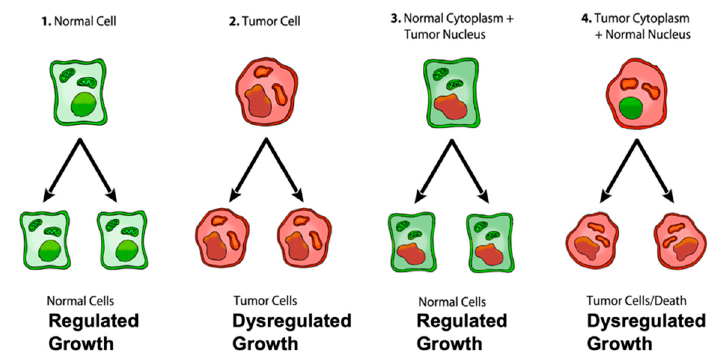
Figure 1. Role of the nucleus and mitochondria in the origin of tumors. Normal cells are shown in green with nuclear and mitochondrial morphology indicative of normal gene expression and OxPhos function, respectively. Tumor cells are shown in red with abnormal nuclear and mitochon- drial morphology indicative of genomic instability and abnormal OxPhos function, respectively. “(1) Normal cells beget normal cells with regulated growth. (2) Tumor cells beget tumor cells with dysregulated growth. (3) Transfer of a tumor cell nucleus into a normal cytoplasm begets normal cells that have regulated growth, despite the presence of the tumor-associated genomic abnormalities. (4) Transfer of a normal cell nucleus into a tumor cell cytoplasm begets dead cells or tumor cells with dysregulated growth”. The